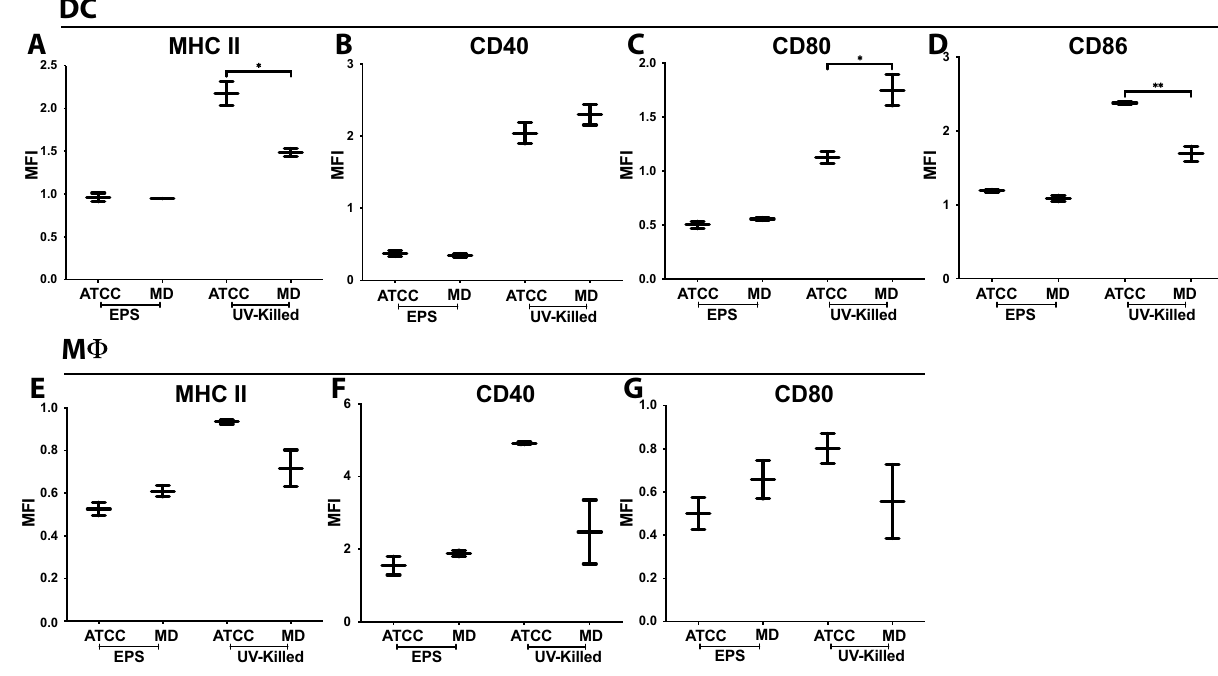
Figure 1. Bifidobacterium alters DC and MΦ surface phenotype. DC and MΦ cultured with media alone (to which treatment groups are normalized), ATCC25526 (ATCC) or UMB-MBP-01 (MD) UV-killed Bifidobacterium or EPS derived from each strain. After 24 h of culture, cells analyzed by flow cytometry. DC gated on live CD11c + , and MΦ gated on live F4/80 + populations. DC stained for ( A ) MHC class II, ( B ) CD40, ( C ) CD80, and ( D ) CD86. MΦ stained for ( E ) MHC class II, ( F ) CD40 and ( G ) CD80. MFI: normalized mean fluorescence intensity; MFI values normalized to control and compared using one-way ANOVA. * p value <